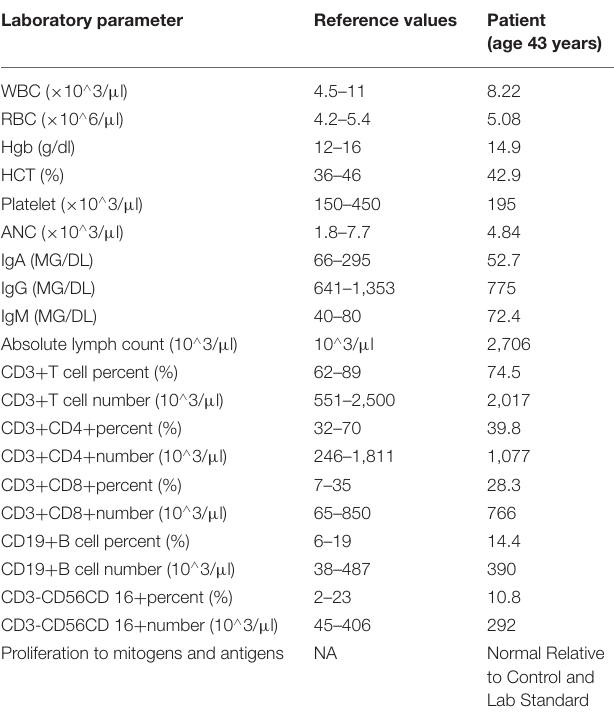
TABLE 1 | Relevant immunologic findings for